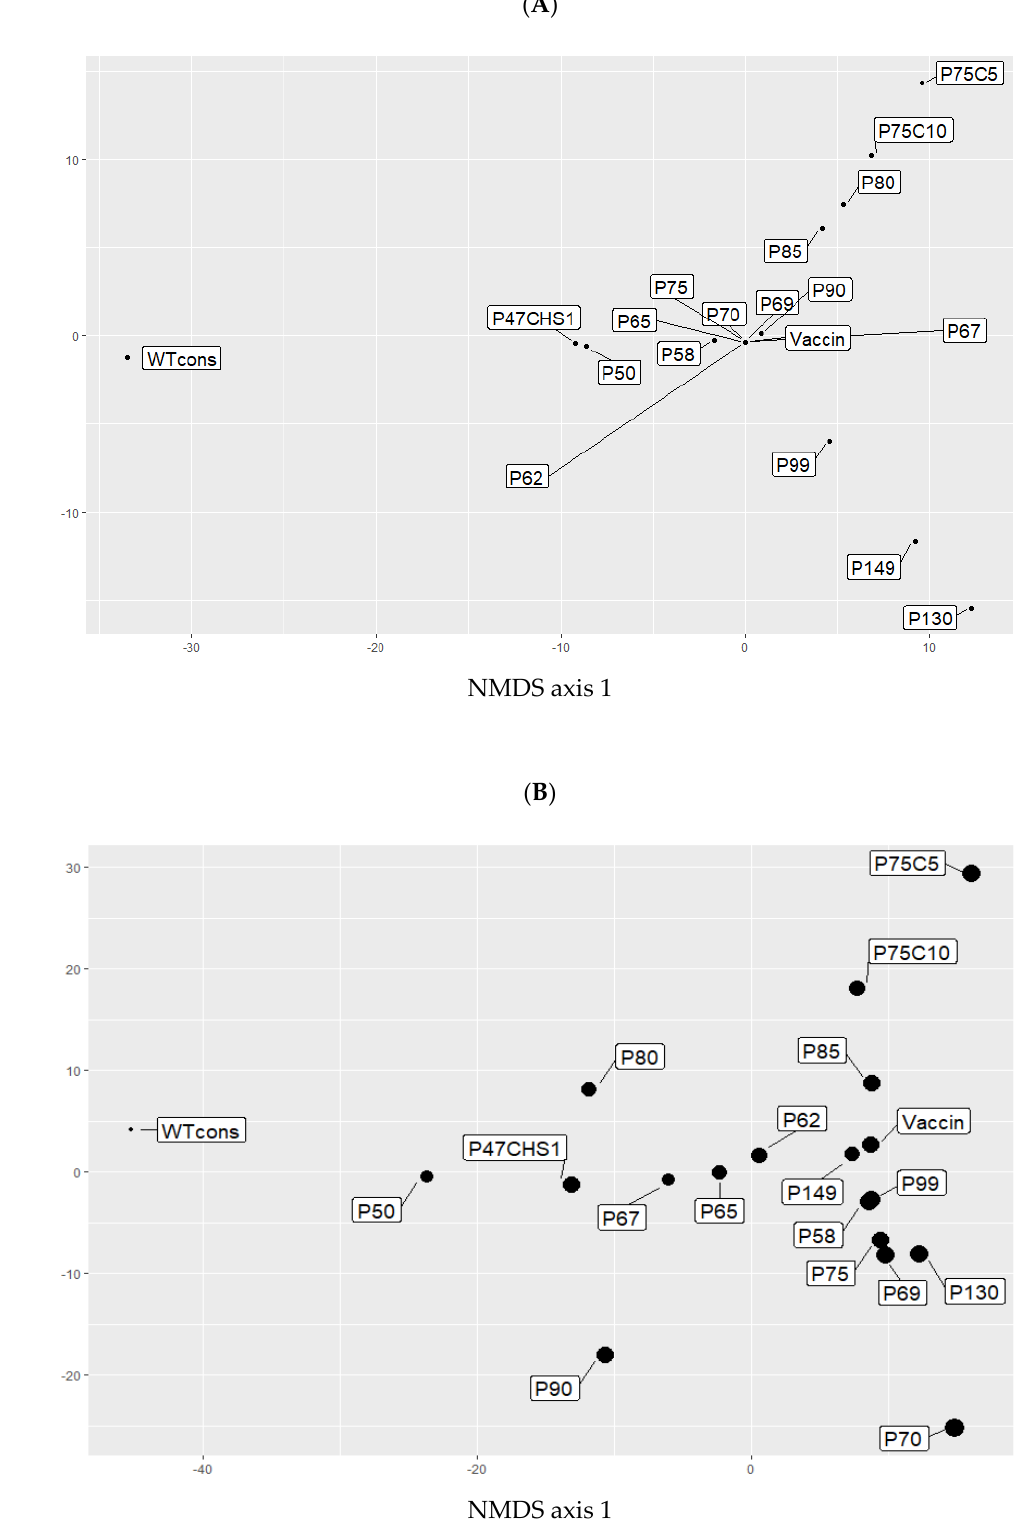
Figure 3. Non-metric multidimensional scaling (NMDS) between each sequenced passage. The obtained NMDS was calculated from matrix (Supplementary Table S2). A: NMDS of consensus sequence, B: NMDS of intraspecific diversity. WT cons: Wild type consensus. P47CHS1: Passage 47 on Vero cells + one passage on CHS cells. P50 50th passage on Vero cells (like other P ... in these